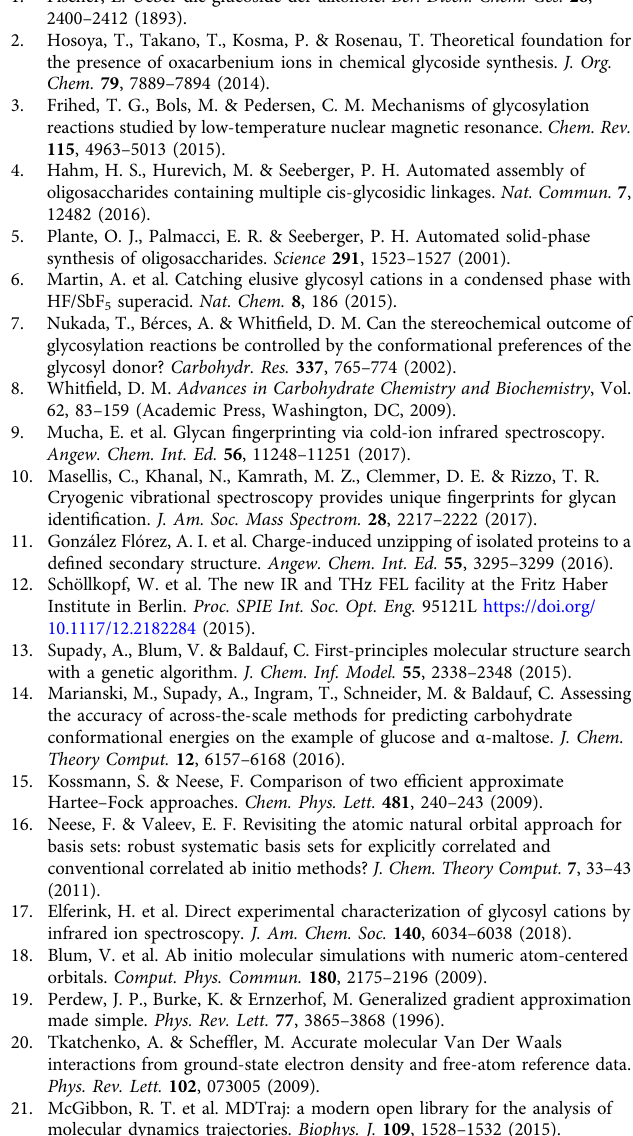
Supplementary Table 3) and performed geometry optimization at PBE0 + D3/6-311 + G(d,p) level of theory 26 with default convergence criteria in Gaussian 09,